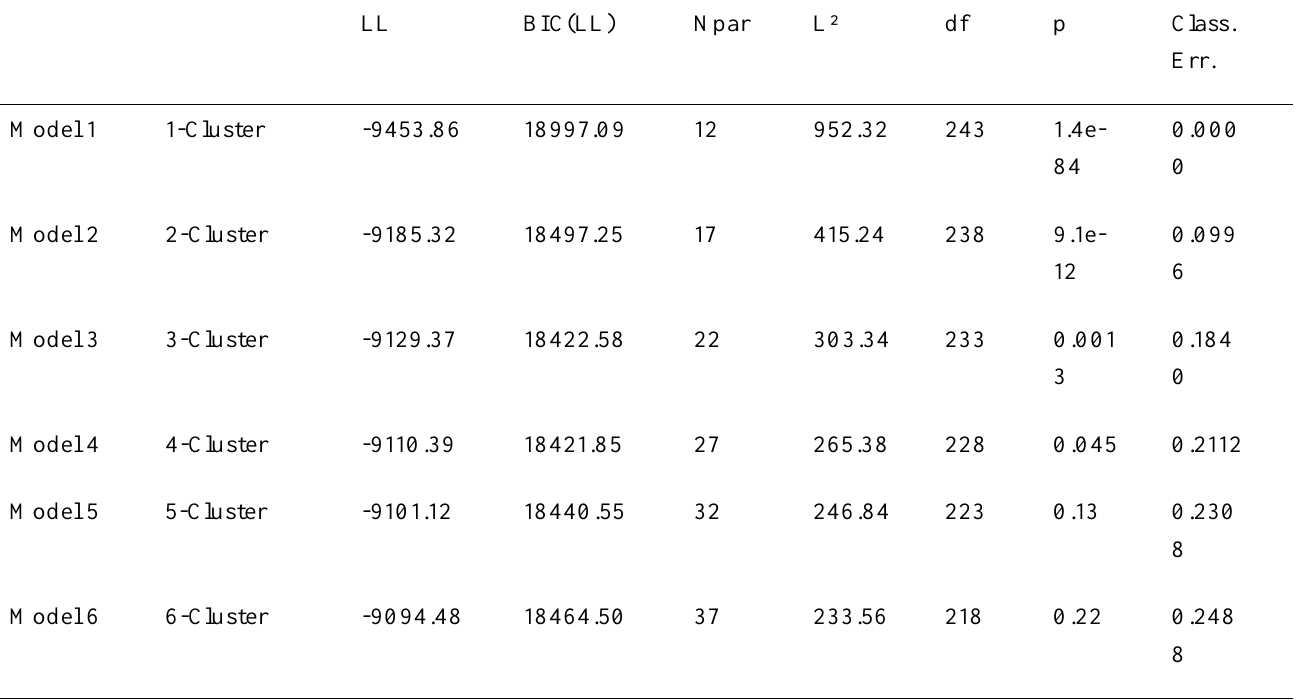
Table 2 Overview 1- to 6-Cluster